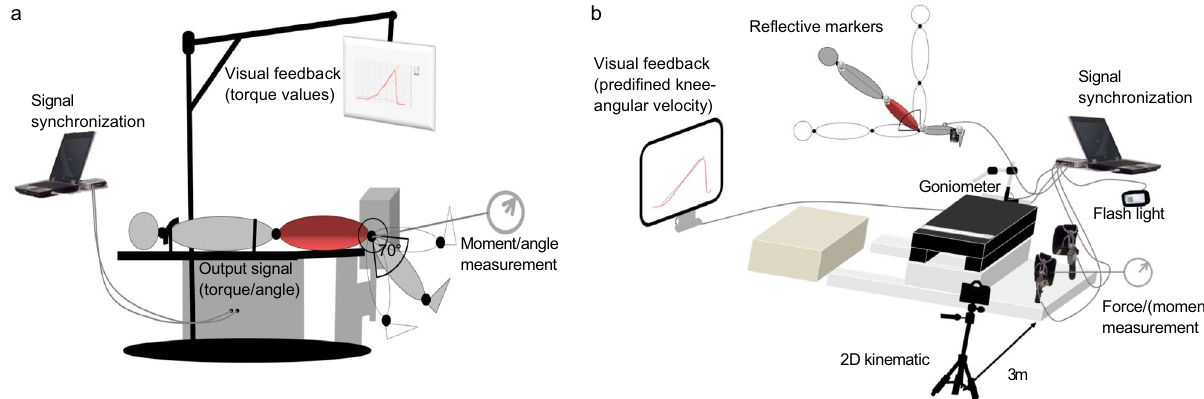
Figure 1. Measurement setups of the isokinetic dynamometer ( a ) and the Nordic hamstring device ( b ). The IsoMed 2000 dynamometer was calibrated according to the manufacturer’s specification, and the device